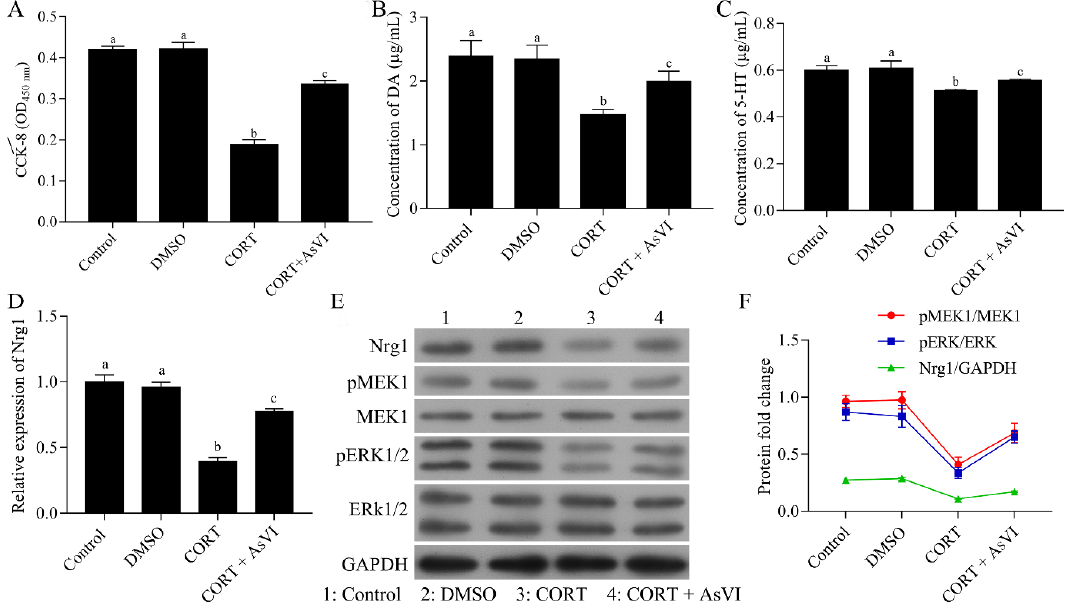
Figure 6. Protective effects of AsVI on CORT-induced PC12 cells. ( A ) The cell viability was measured by a CCK-8 assay. ( B ) HPLC analysis was carried out to measure the DA release levels for various therapies in PC12 cells. ( C ) HPLC analysis was carried out to measure 5-HT release levels for various therapies in PC12 cells. ( D ) A quantitative real-time PCR method was conducted to detect the expression level of NRG-1 mRNA in different treated PC12 cells. ( E , F ) Western blot for NRG-1, MEK1, p-MEK1, ERK1/2 and p-ERK1/2 protein for different treatments in PC12 cells. All the experiments were conducted thrice. Data are articulated as Mean ± SD. Distinct letters (a, b, c, d)denote significant differences in various cohorts p <